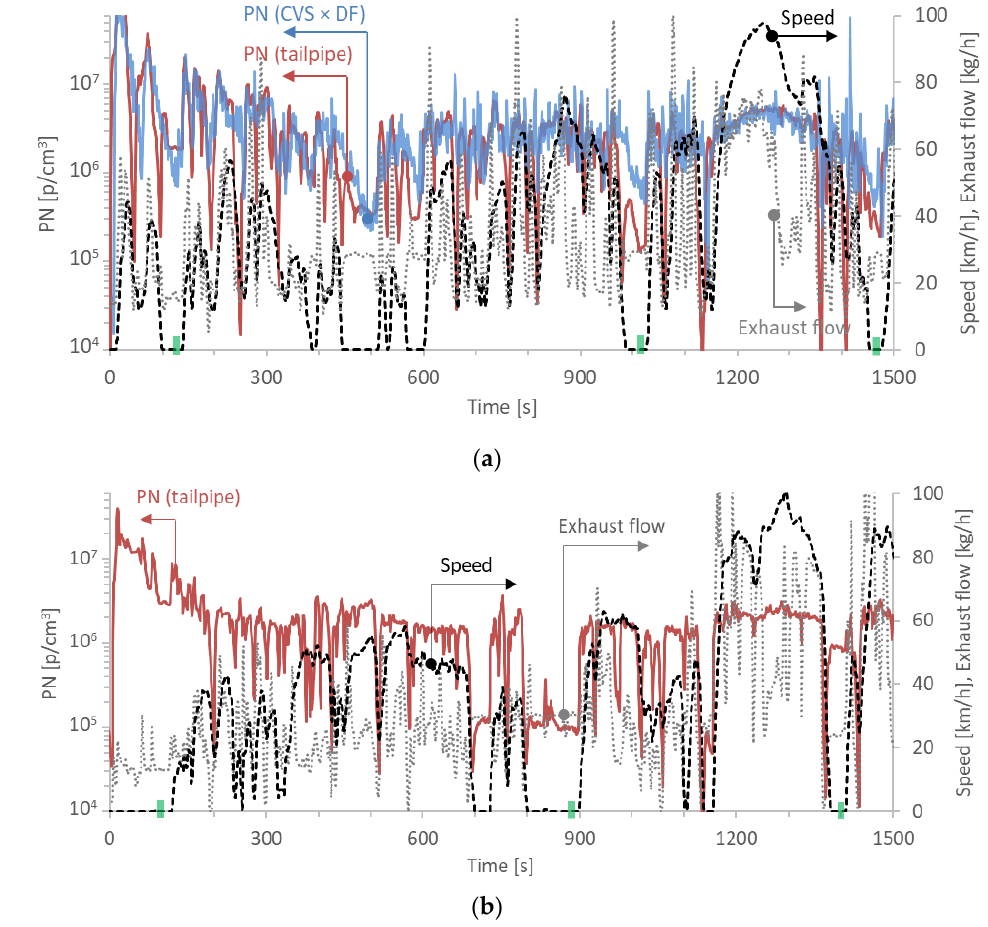
Figure 2. Real time particle number (PN) emissions, exhaust flow rate and speed trace for the first 1500 s of: ( a ) a WLTC (upper panel) and ( b ) a RDE test (lower panel) of a Gasoline Direct Injection (GDI) vehicle. Arrows indicate the appropriate y-axis. The green indexes at the time x-axis show the period that idle concentrations were calculated. CVS = Constant Volume Sampling; DF = Dilution Factor; RDE=Real-Driving Emissions; WLTC = Worldwide harmonized Light vehicles Test Cycle.